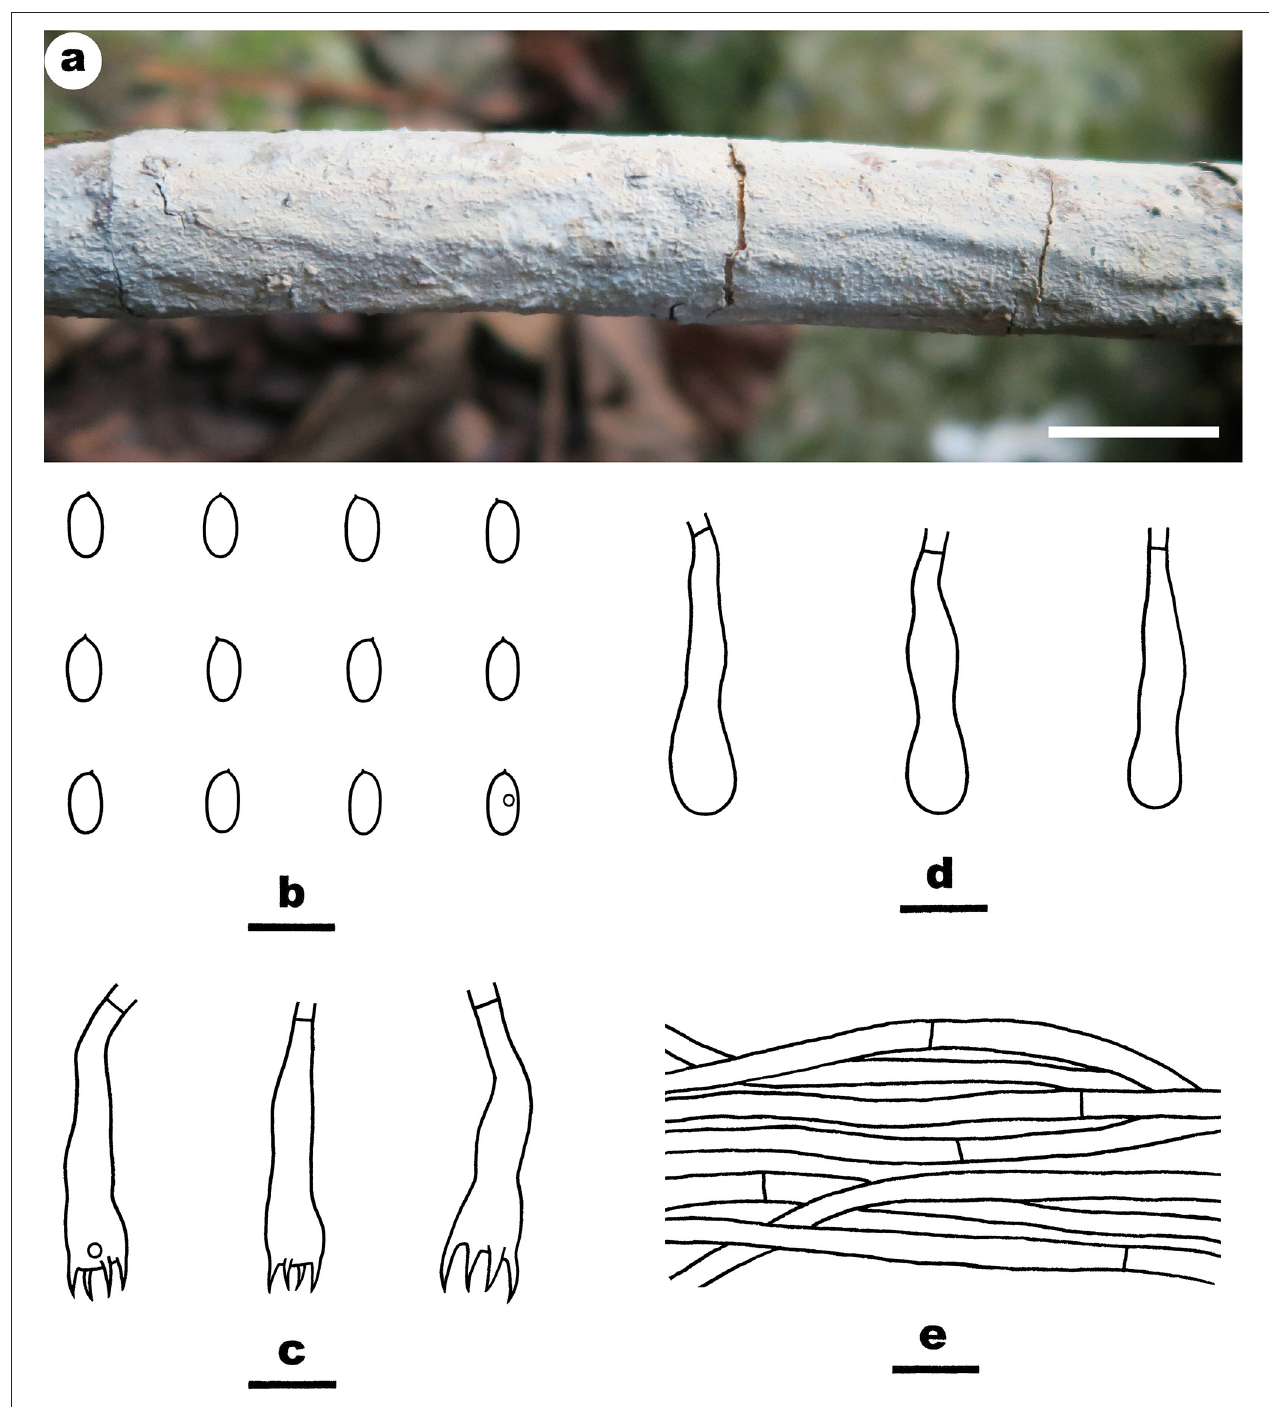
FIGURE 5 | Efibula shenghuae (from the holotype He 3384; scale bars: a = 1cm; b–e = 10 µ m). (A) Basidiomata. (B) Basidiospores. (C) Basidia. (D) Basidioles. (E) Hyphae from subiculum. H. Wu and E. americana Floudas and Hibbett. Morphologically, Notes— Efibula taiwanensis Figure 6 is characterized by E. subglobispora differs from E. taiwanensis by having having membranaceous to pellicular basidiomata and broadly ellipsoid to ovoid basidiospores. In the phylogenetic tree, E. taiwanensis is sister to E. subglobispora C.C. Chen and Sheng